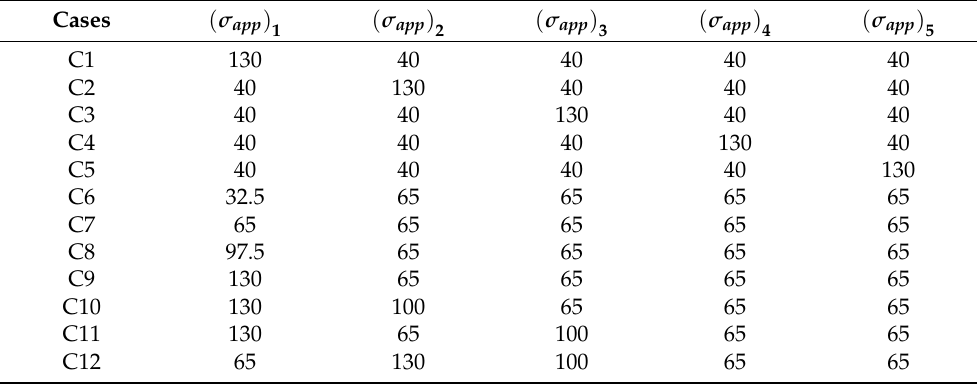
Table 3. Twelve variable-amplitude cyclic loading cases (unit: